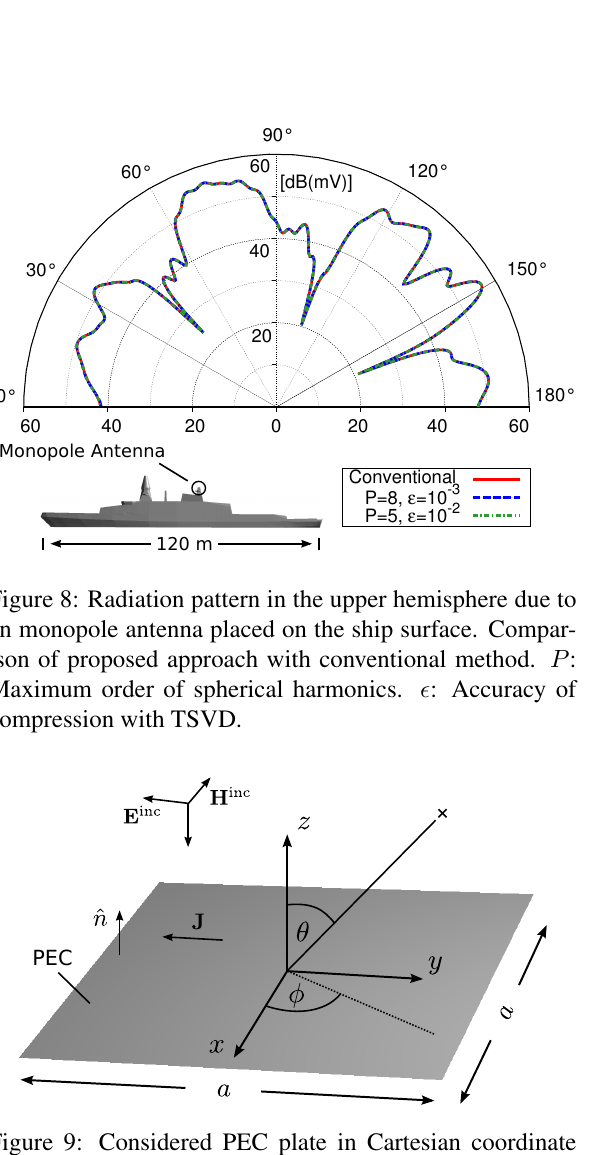
Figure 9: Considered PEC plate in Cartesian coordinate system. Excitation with plane wave, incident angle is θ = 0 .